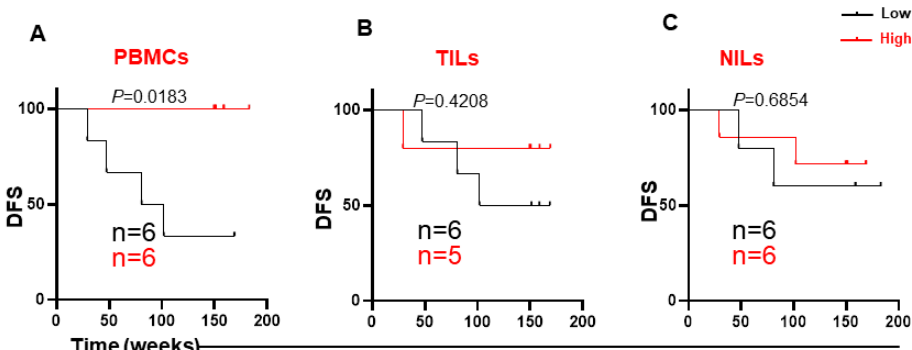
Figure 7. Kaplan–Meier curves of DFS based on levels of CD3 + CD4 − TIM-3 + in PBMCs, TILs, and NILs in the group of patients with LVI. Patients in the presence of LVI were divided into high and low groups for TIM-3 expression in PBMCs ( A ), TILs ( B ), and NILs ( C ), and DFS was determined for these groups. The number of patients included in each comparison are specified on each survival curve.